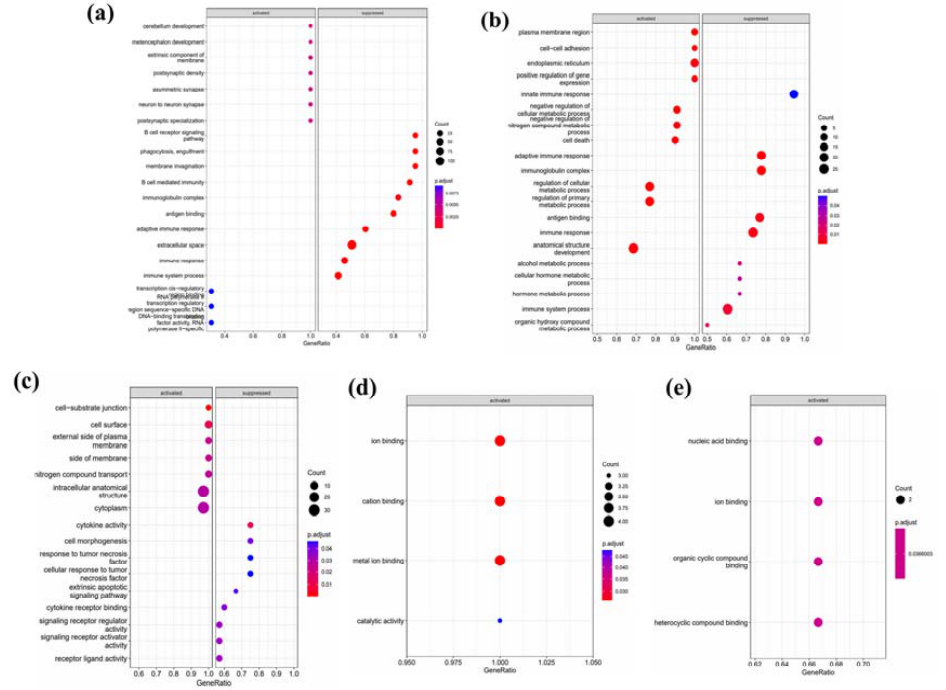
Figure 3. Functional pathway analysis of differentially expressed genes. ( a ) Biological and func- tional pathways of the genes upregulated in the short survival group were analyzed. Genes medi- ating neural development were upregulated, and genes mediating immune response were down- regulated. Functional pathway analysis of the genes in ( b ) group 1, ( c ) group 2, ( d ) group 4, and ( e ) group 5 was also